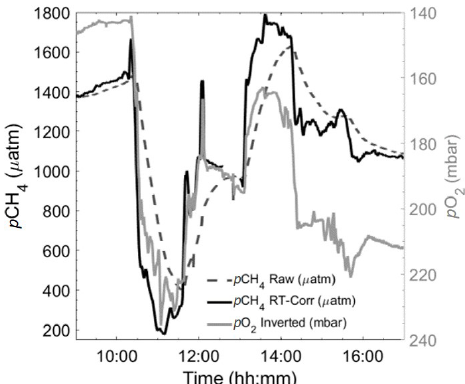
Figure 6. Section of a 24h cycle of data from the autumn limnic cruise (Rom3), showing raw (black dashed line) and RT-Corr (black solid line) p CH 4 µatm measured by the HC–CH 4 with inverted p O 2 mbar (grey line) as a technically independent, yet parameter-wise, linked reference for real-time spatiotemporal variability, i.e. RT O 2 sensor (cid:28) RT CH 4